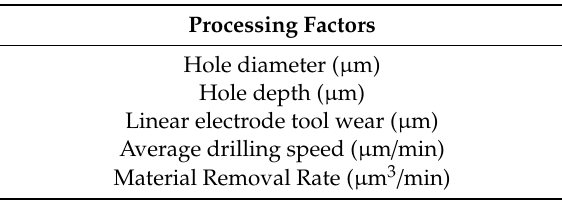
Table 4. Output process factors and measures.